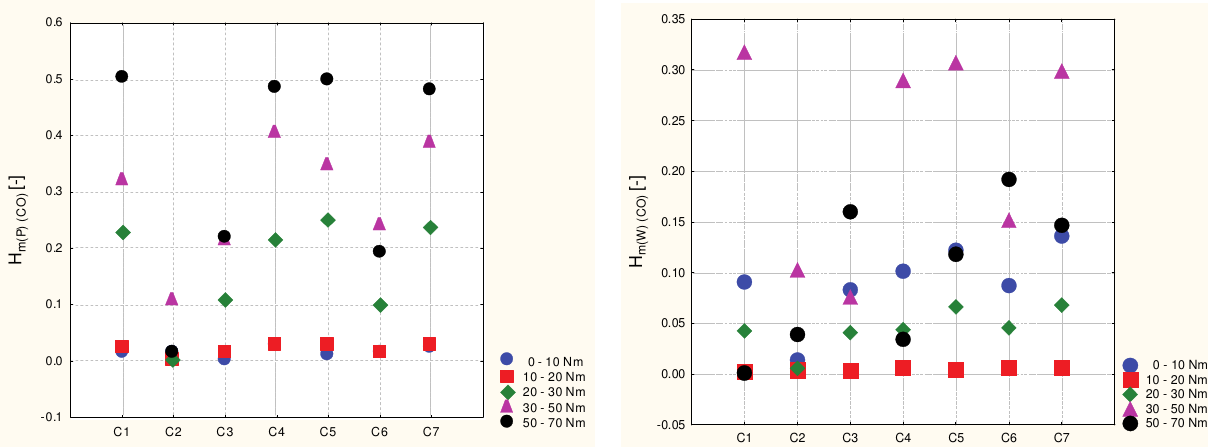
Fig. 3. Values of the information capacity index H m for CO and the transient state at n = 1100 r/min and a change of load from T tq = 0 Nm to T tq = 70 Nm: P – delayed angle of injection advance; W – accelerated angle of injection advance; C 1 – C 7 – combinations of illustrative variables